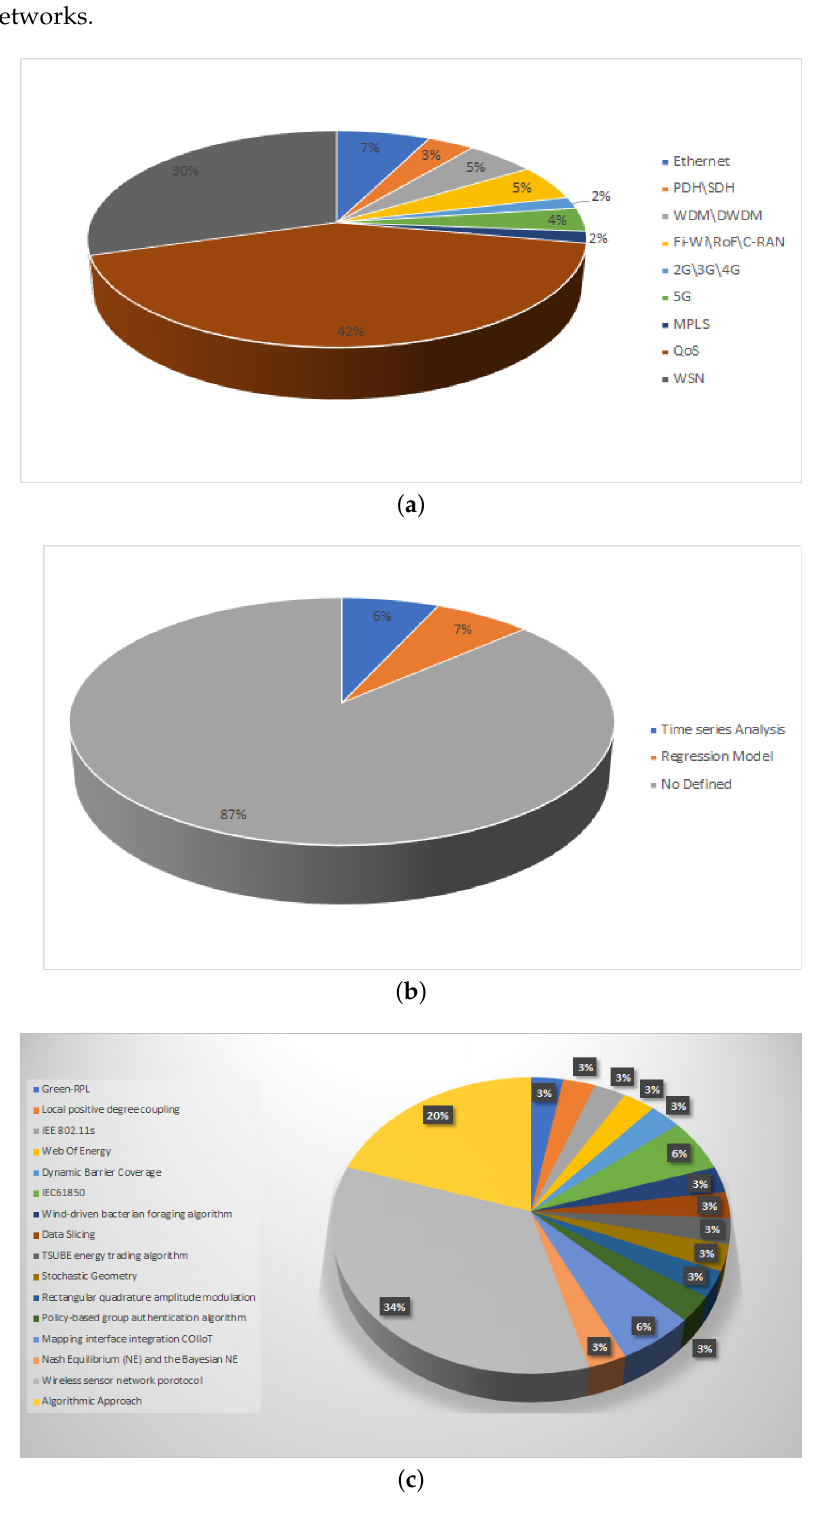
Figure 6. Classification: ( a ) Connectivity used in the Smart Grid, ( b ) Tools used for the analysis of Smart Grids, and ( c ) Protocols Applied in Smart Grid